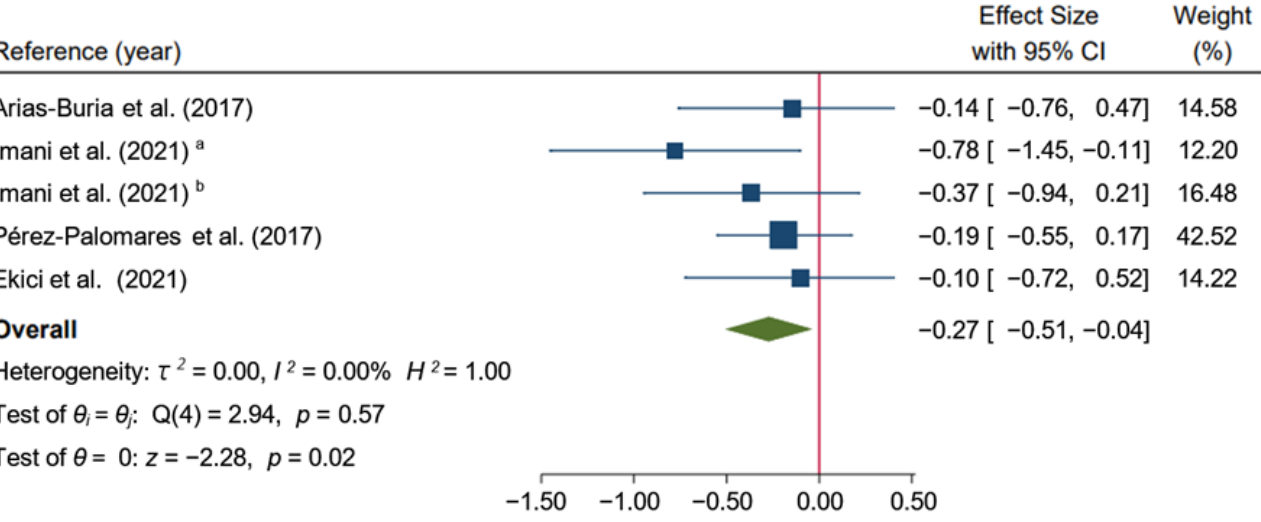
Figure 5. Forest plot of comparison at the mid-term: Dry Needling group alone or combined with exercise therapy versus other types of intervention (exercise therapy, stretching, massage, or a combination of all of them plus hot packs and analgesic electrotherapy), outcome: Pain. a : Hong’s dry needling technique (fast-in fast-out intervention); b : Deep dry needling (static needling) [32–35]. Regarding disability, the meta-analysis found no significant differences between the dry needling group alone or combined with exercise therapy compared to other types of interventions, such as exercise [33] or a combination of exercise, massage, passive mobilization [34] plus hot packs and analgesic electrotherapy [32] in the short-term and suggest that dry needling had a large effect (SMD: − 0.97; 95% CI: − 2.04 to 0.11; I 2 = 93.11%; p = 0.08; very-low quality evidence) (Figure 6).